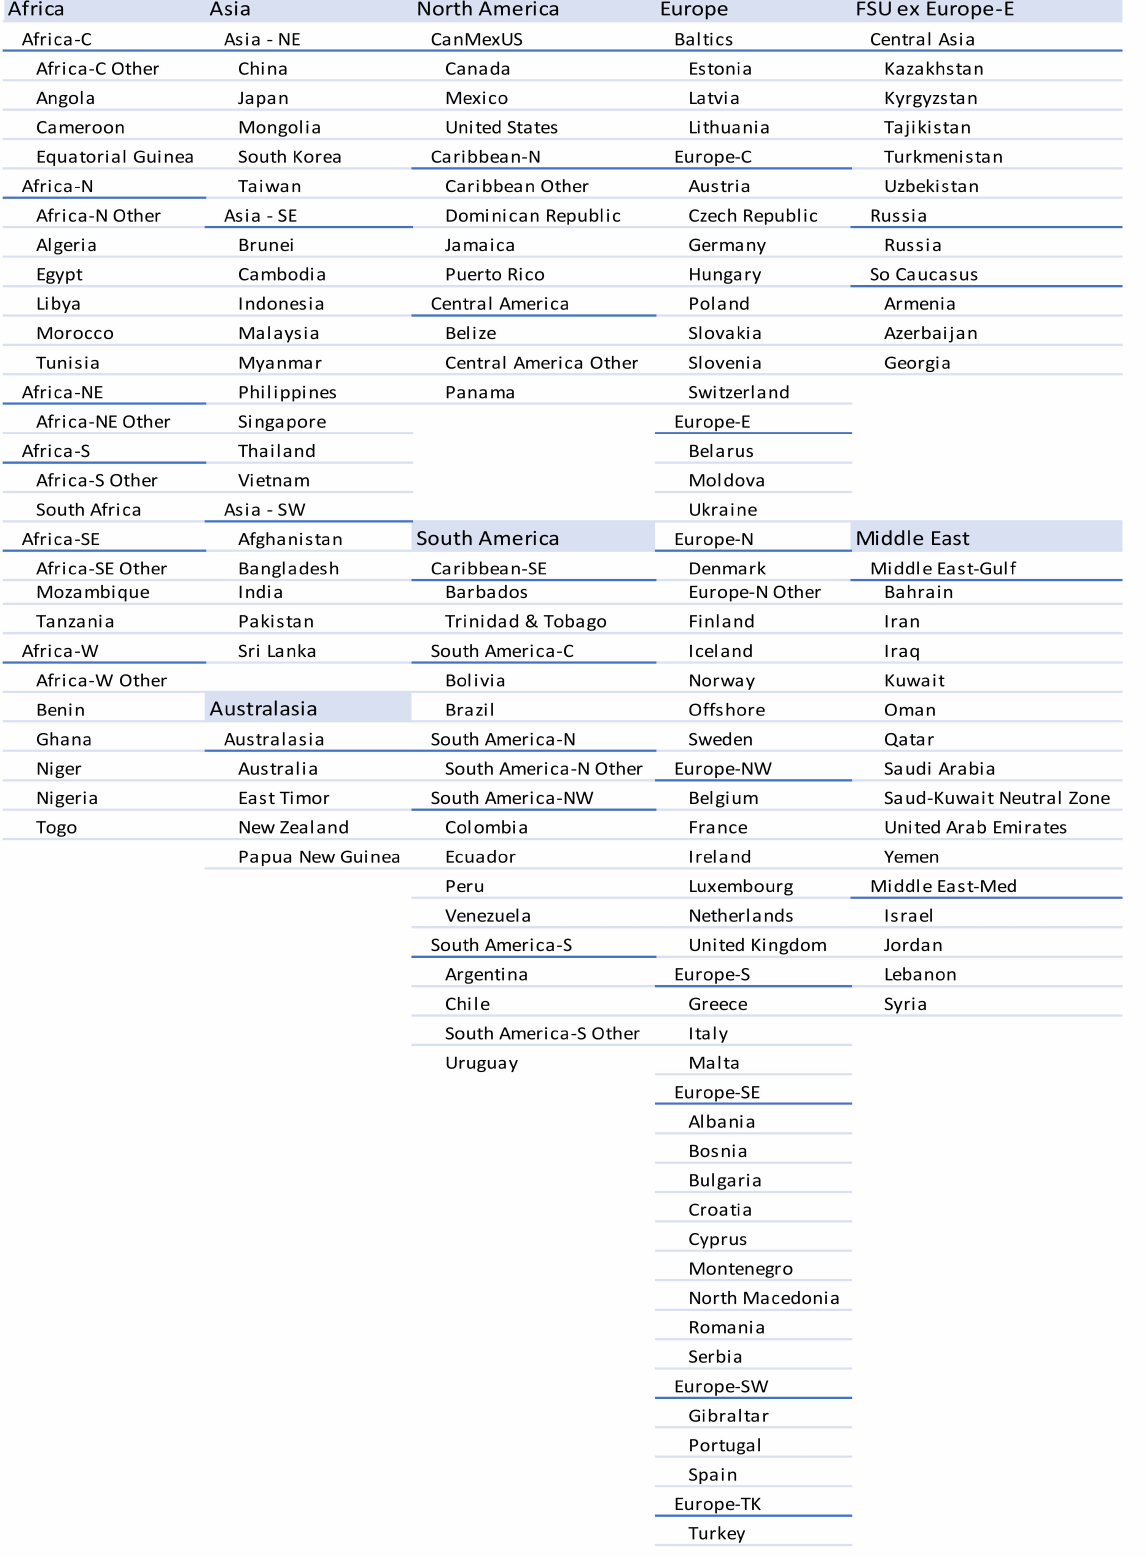
Figure A1. G2M2 ® geographic